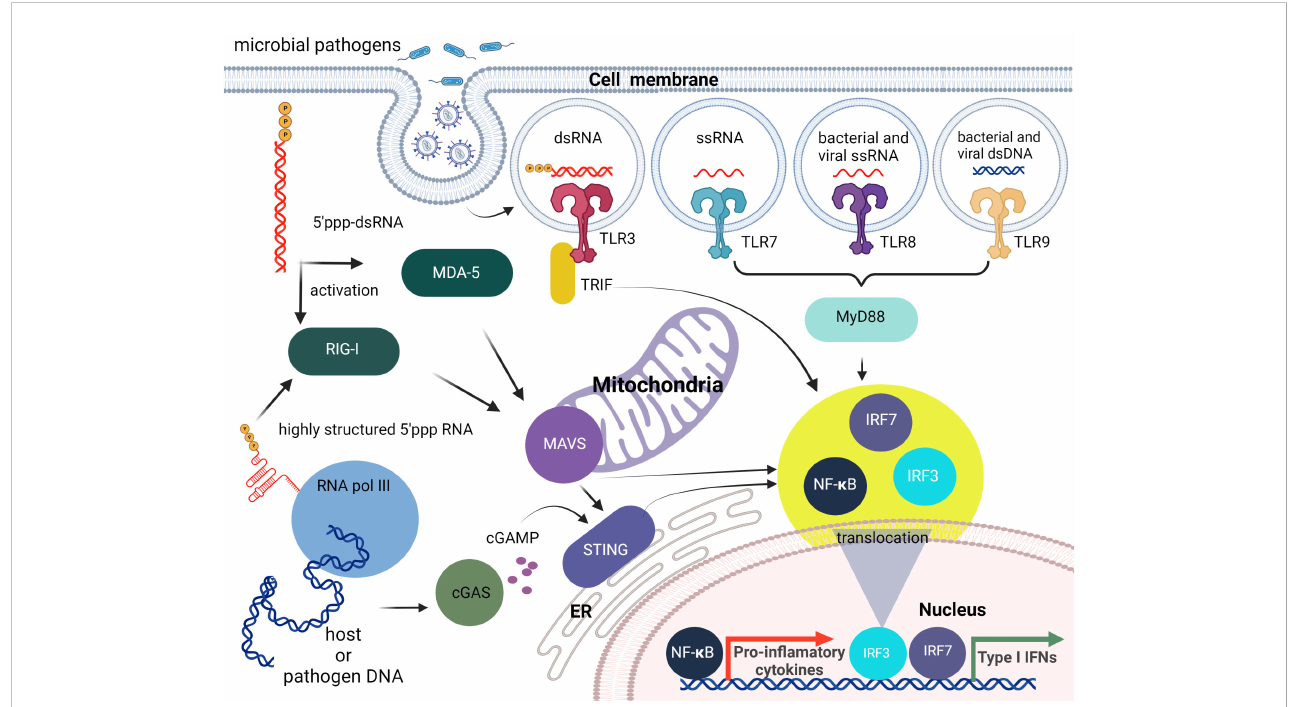
FIGURE 1 Brief overview of cellular innate immunity with an emphasis on nucleic acid recognition. The fi rst line of nucleic acid PRRs consists of TLRs that can sense different PAMPs speci fi c for non-self nucleic acids. Then cytosolic pathogen-associated nucleic acids can be sensed by members of the RLR family (RIG-I, MDA5). The endogenous and viral DNAs can also lead to RIG-I activation following their transcription by cytosolic RNA pol III, or can be detected directly as dsDNAs via cytosolic DNA sensing systems such as the cGAS-cGAMP-STING pathway. All of these pathways initiate the translocation of transcription factors including IRF3/7 and NF- k B to the nucleus and the subsequent induction type I IFN and pro-in fl ammatory cytokine